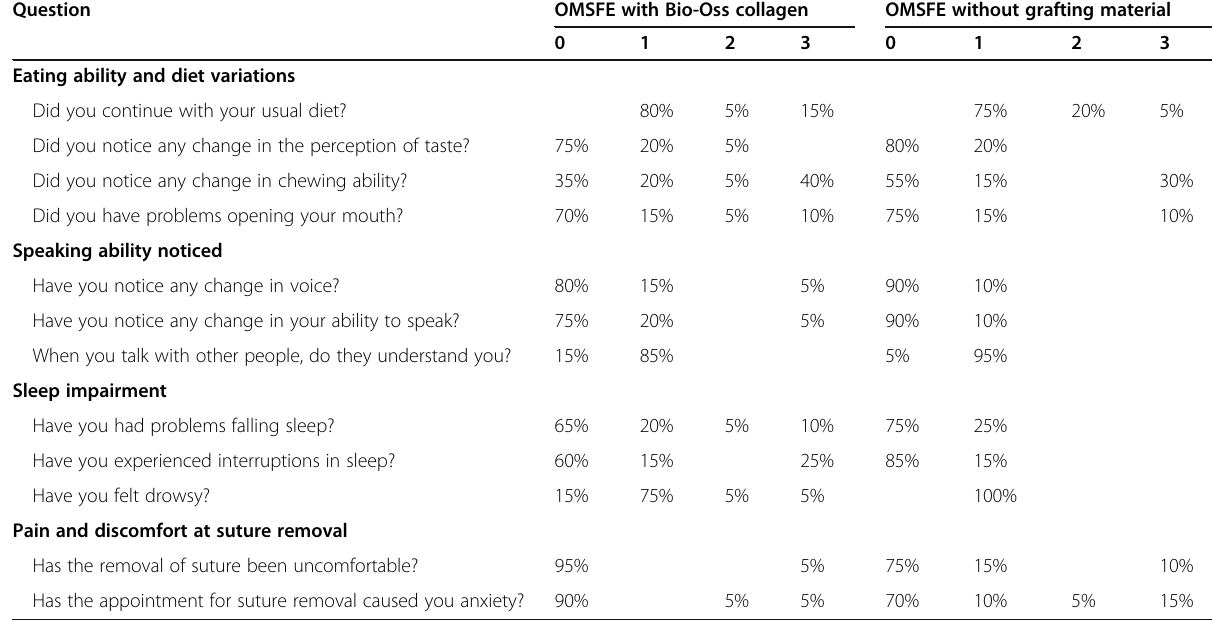
Table 5 Questionnaire assessing eating and speaking ability, diet variations, sleep impairment, pain, and discomfort at 1 week